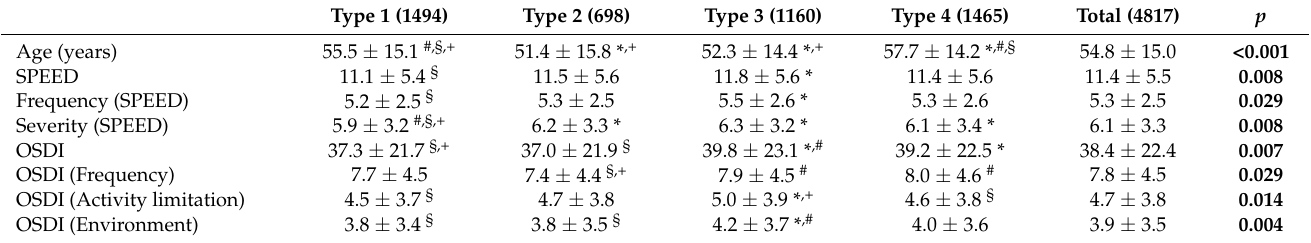
Table 1. Differences in age and symptom questionnaires among dry eye subtypes.